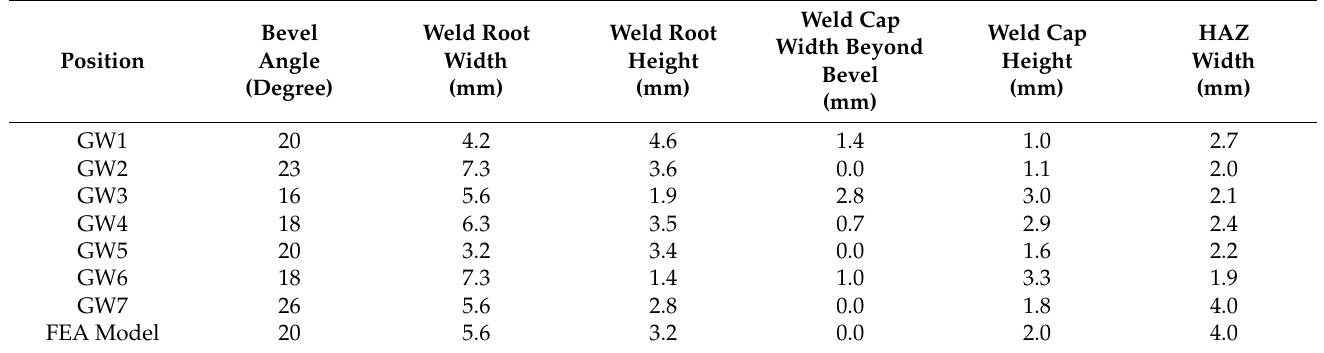
Table 2. Longitudinal tensile properties of the pipe.